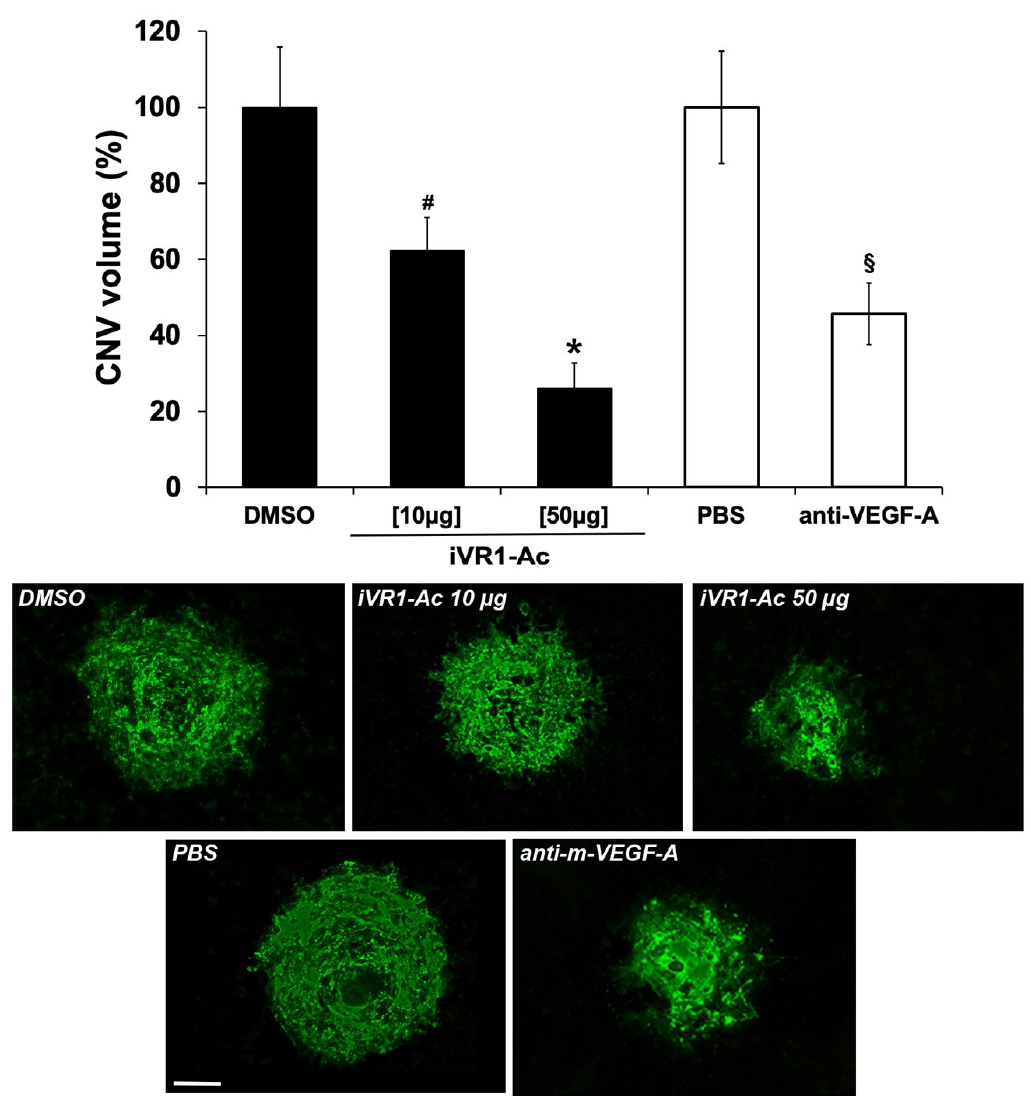
Figure 2. iVR1-Ac inhibits laser-induced choroid neovascularization (CNV) in a dose-dependent manner after intravitreal delivery. After 7 days from laser-induced damage, CNV volumes were measured by Isolectin B4 staining of RPE-choroid flat mounts. N = 5 mice per group. The following number of spots were analyzed: DMSO = 14, iVR1-Ac [10 μg] = 12, iVR1-Ac [50 μg] = 15; PBS = 10, anti-m-VEGF-A = 8. Data are presented as the mean ± SEM. * p = 0.0002 and # p = 0.0464 vs. DMSO; § p = 0.001 vs. PBS. On the bottom, representative pictures of CNV are shown. Scale bar: 100 μm.